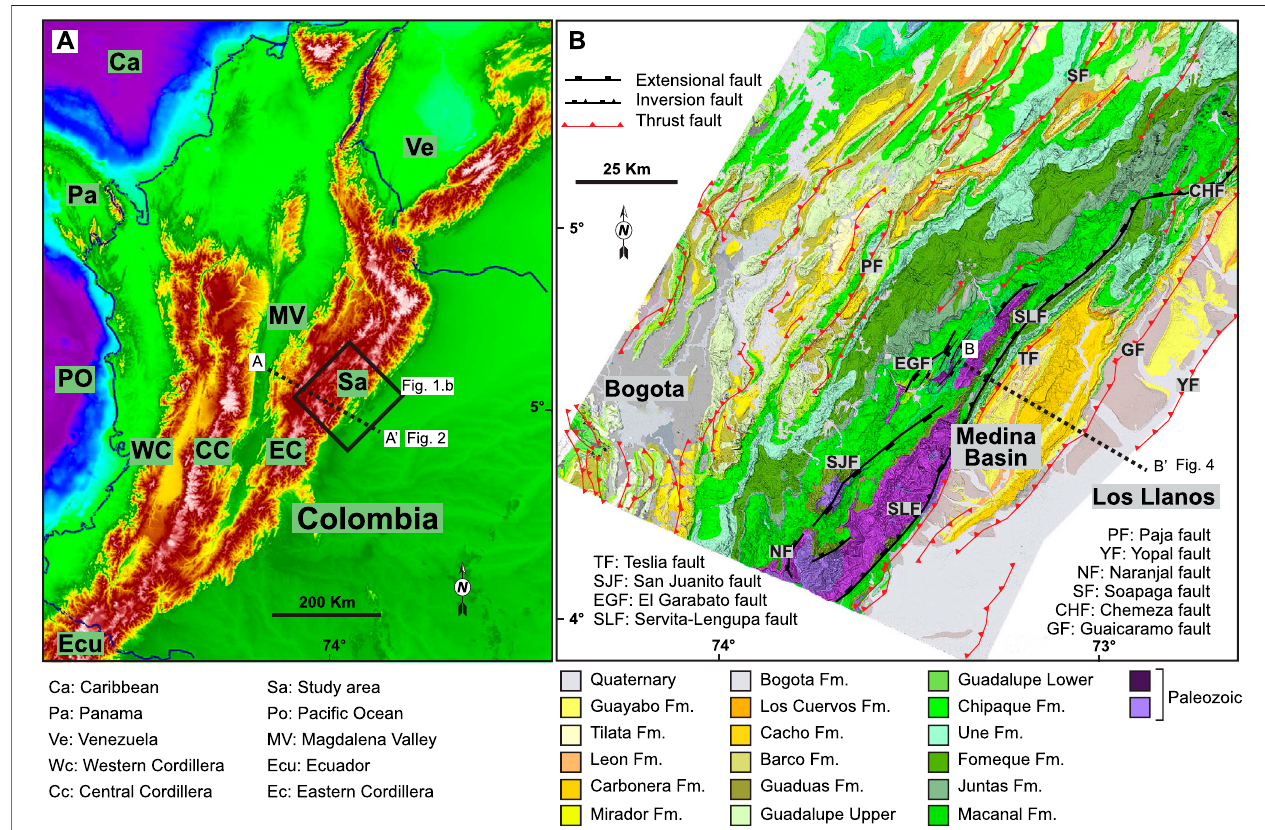
FIGURE1 | Regional DigitalElevation Model (DEM), and detailed geological map ofthe study area. (A) Principal tectonic elements ofthe North Andes withlocation of the study area. (B) Structural and stratigraphic map of the study area (modi fi ed from Parra et al., 2009a).